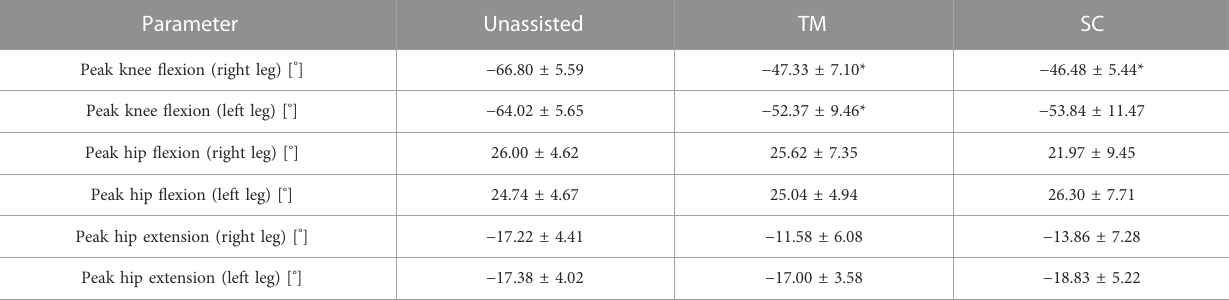
TABLE 2 Lower-limb kinematics calculated by the 3D-motion analysis system Vicon for all experimental conditions assessed: Unassisted, Transparent Mode (TM), and Stance Control (SC) (mean ± std). Asterisks indicate signi fi cant differences from unassisted condition (Bonferroni, p < 0.05).